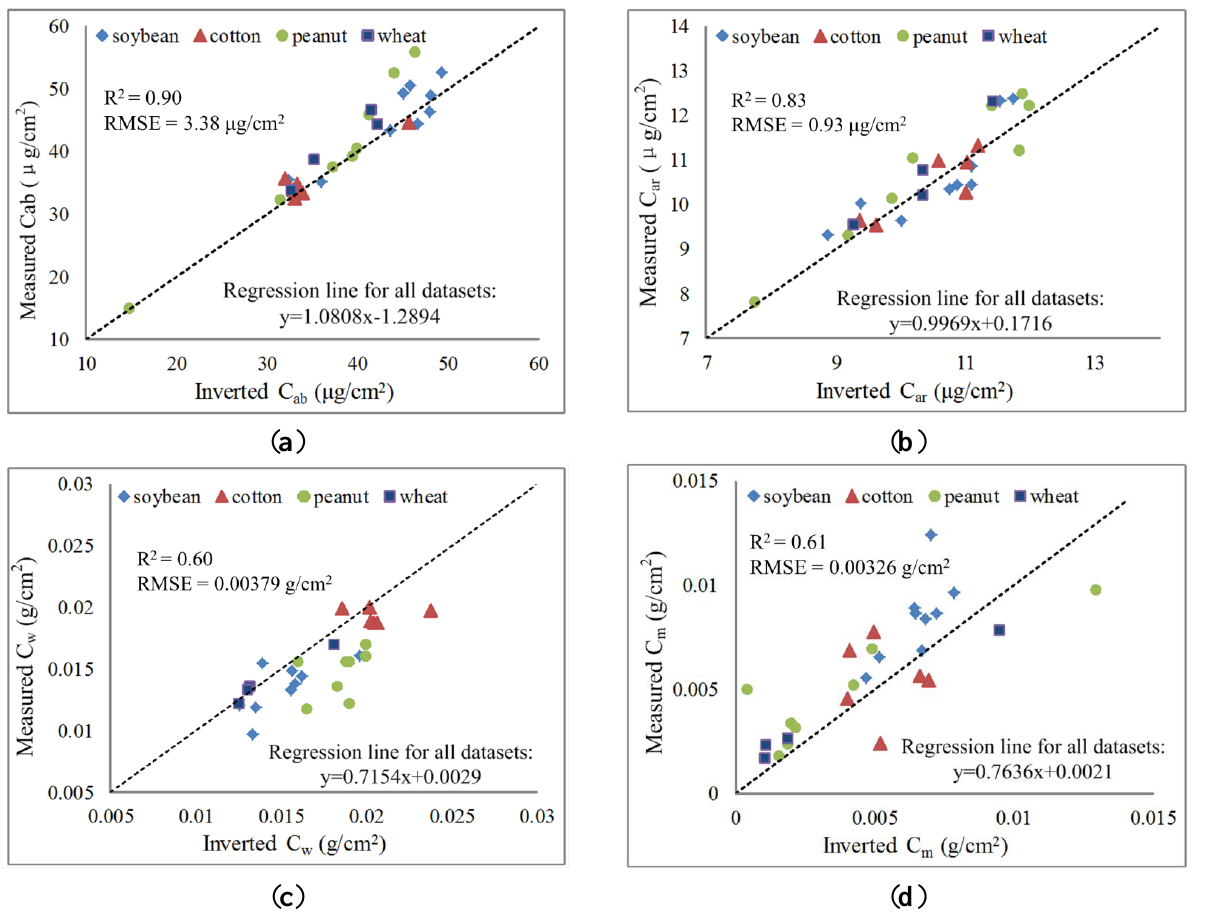
Figure 7. Scatter diagram of inverted and measured values of the chlorophyll content ( a ); carotenoid content ( b ); water content ( c ); and dry matter content ( d ) for four crop